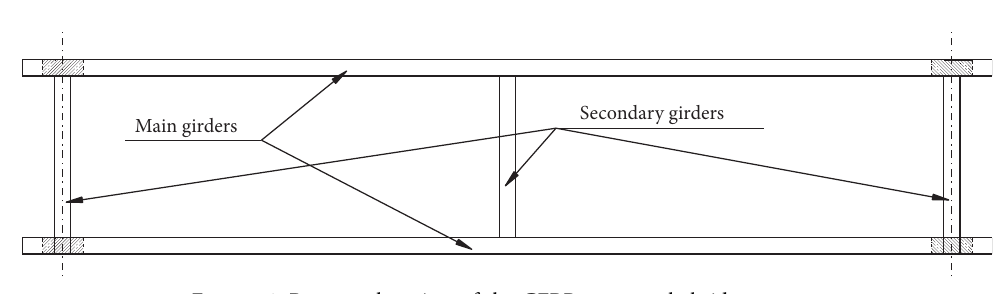
Figure 4: Bottom plan view of the GFRP-concrete hybrid structure. Table 2: Main properties of the GFRP pultruded profiles.